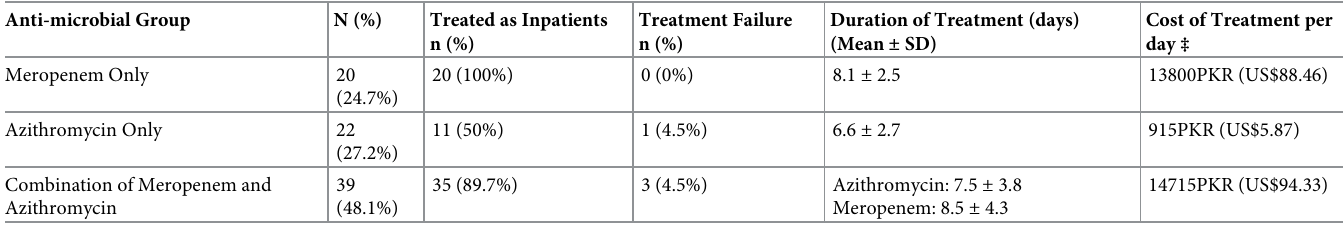
Table 2. Clinical Outcome of patients among the three treatment